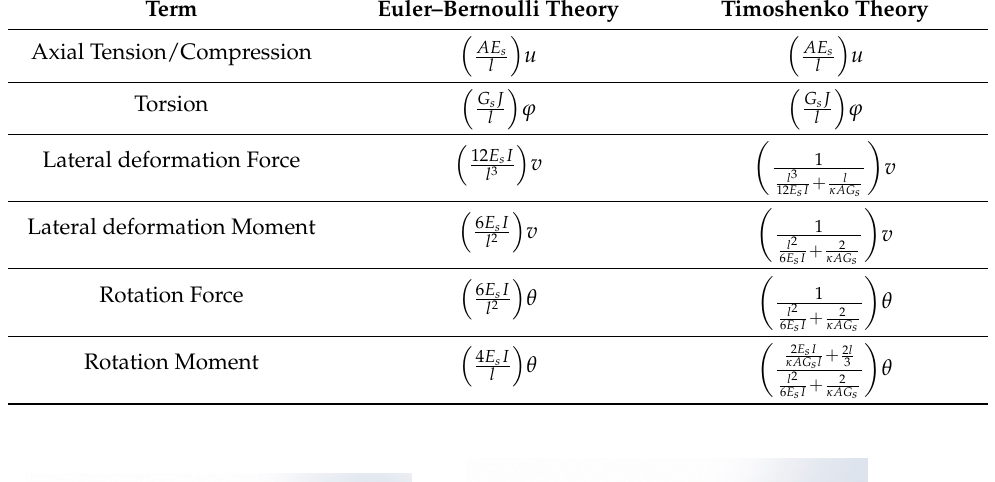
Table 1. Conversion table for converting mechanical properties relationships based on Euler– Bernoulli beam theory to mechanical properties relationships based on Timoshenko beam theory. Figure 3. Forces and moments required to cause ( a ) lateral displacement, 𝛿, with no rotation at the free end of the beam, ( b ) rotation, 𝜃, with no lateral displacement at the free end of the beam, Term Euler–Bernoulli Theory Timoshenko Theory ( c ) pure axial extension, and ( d ) pure twist in the free end of a Timoshenko beam.